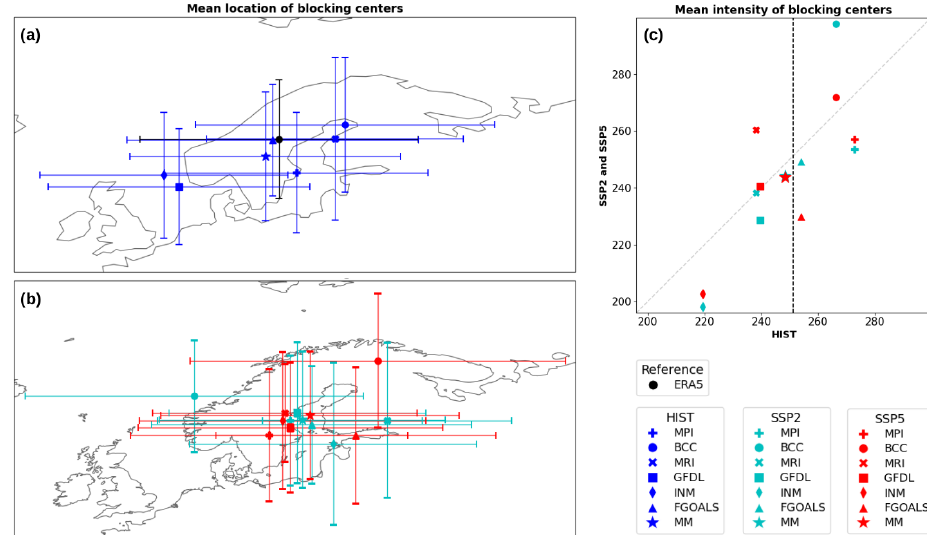
Figure 5. (a–b) Locations of the blocking composite centres averaged over all blocking events for ERA5 and the GCMs during HIST considering (cid:49) Z500 HIST (a) and during SSP2 and SSP5 considering (cid:49) Z500 SSP2 and (cid:49) Z500 SSP5 (b) . The error bars indicate the standard deviations of latitudinal and longitudinal coordinates of the blocking centres. (c) Intensities (in m) of the blocking composite centres averaged over all blocking events during HIST, SSP2, and SSP5 considering (cid:49) Z500 HIST on the x axis and (cid:49) Z500 SSP2 and (cid:49) Z500 SSP5 on the y axis. The dashed black line is the ERA5 mean. (The values are taken from Table S3.)